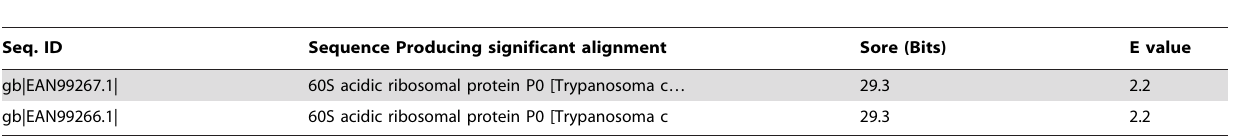
Table 1. Showing the hits in the T. cruzi Proteome as the native source of the TcP0 C-terminus queried.